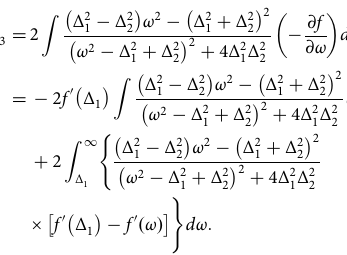
ffiffiffiffiffiffiffiffiffiffiffiffiffiffiffiffiffiffiffiffiffiffiffiffiffiffiffiffi ω þ ν ð ; P ffiffiffiffiffiffiffiffiffiffiffiffiffiffiffiffiffiffiffiffiffiffiffiffiffiffiffiffi ω (cid:1) ν ð